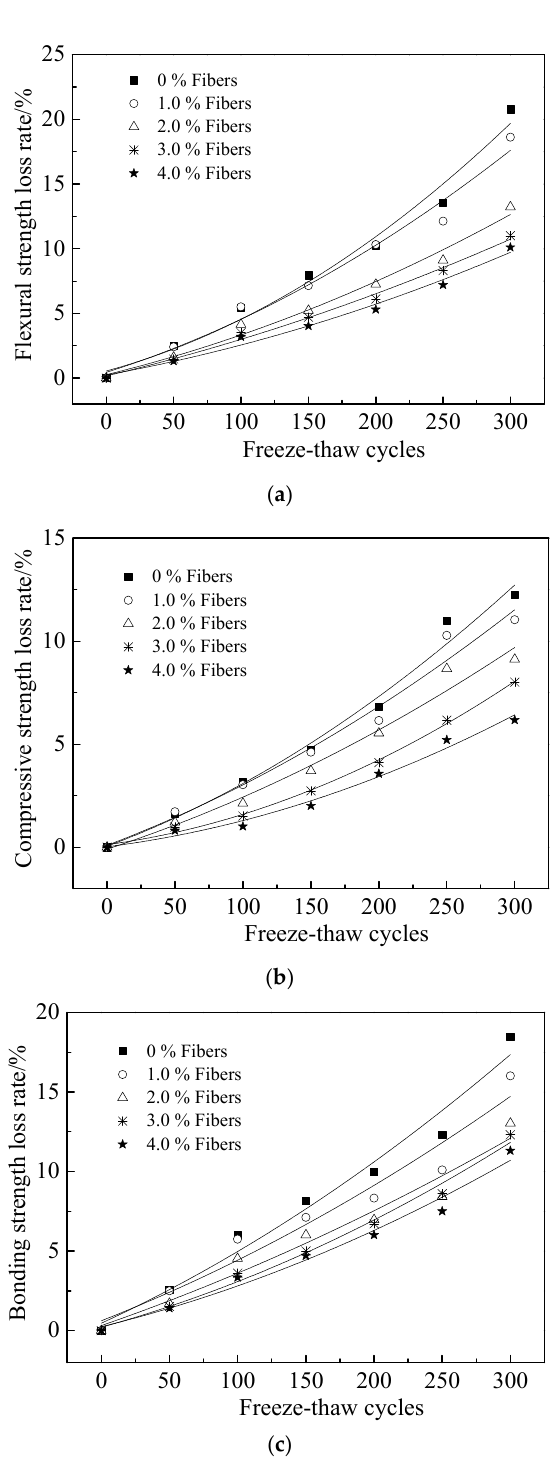
Figure 7. The mechanical strengths loss rate of SAC-RPC during NaCl freeze-thaw cycles. ( a ) The flexural strength loss rate, ( b ) the compressive strength loss rate, ( c ) the bonding strength loss rate.